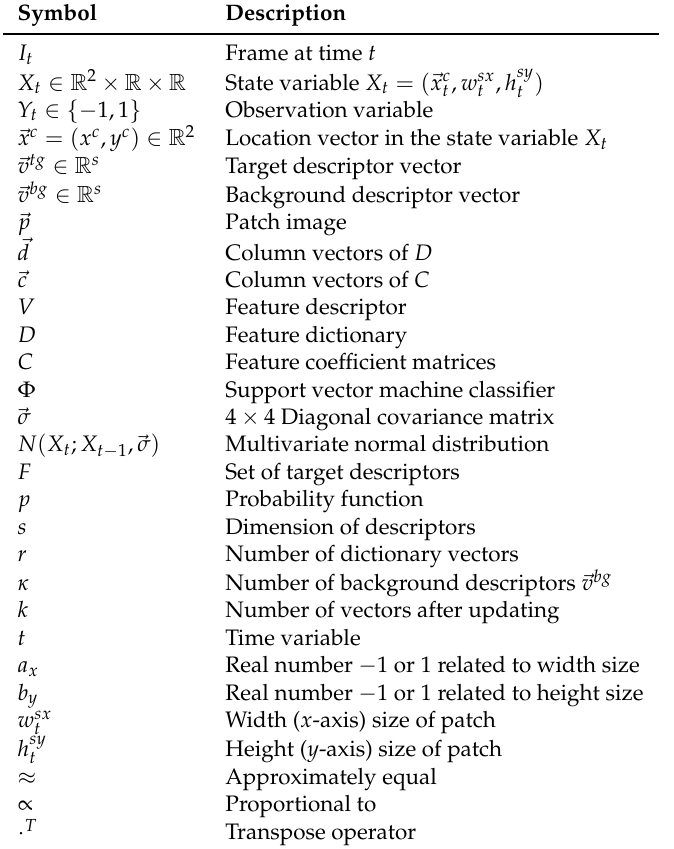
Table 1. Notations and